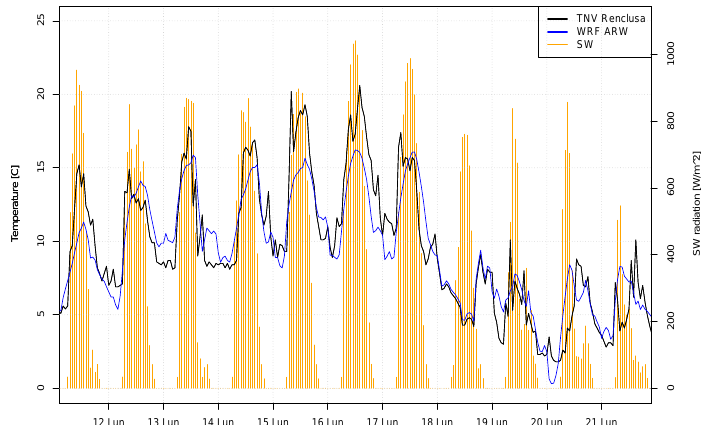
Figure 3. Comparison temperature simulated by the WRF model and measured at Renclusa “telenivometer” (TN1). Orange bars is shortwave radiation simulated by WRF at the same